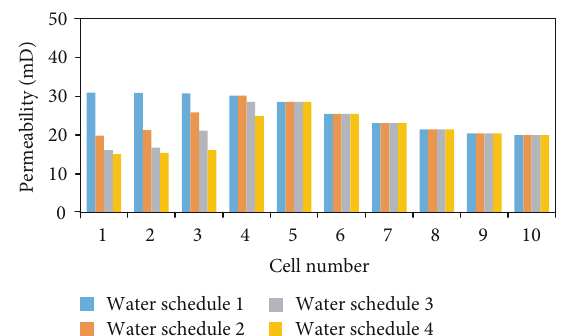
Figure 9: Permeability pro fi les under di ff erent schedules.